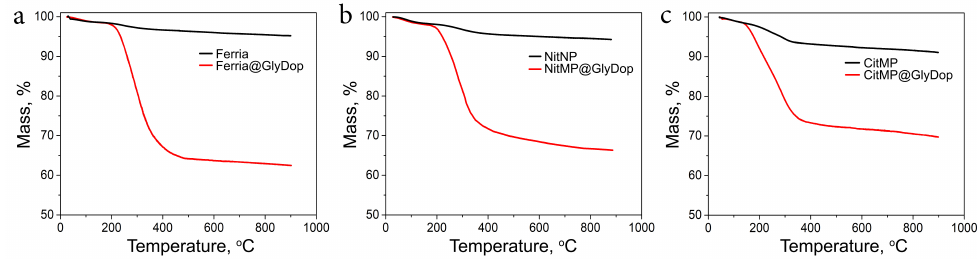
Figure 3. TGA curves of Ferria ( a ), NitMP ( b ), and CitMP ( c ), and the corresponding composites with